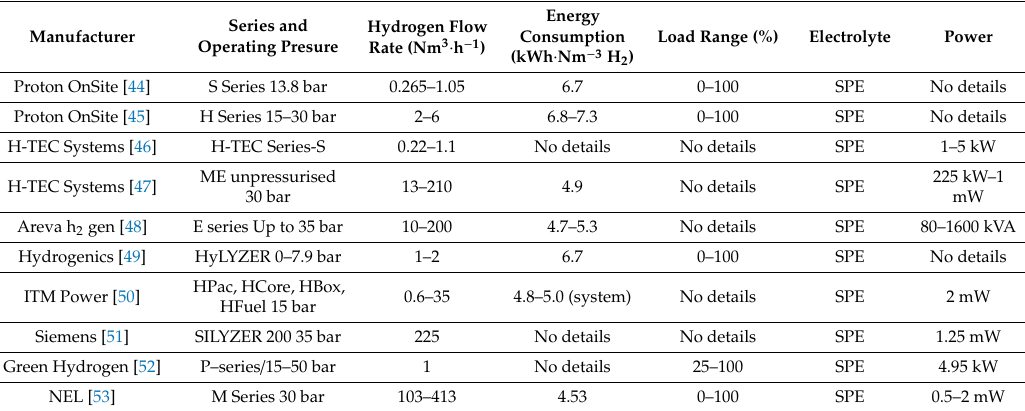
Figure 3. Principle of operation of proton exchange membrane (PEM) electrolyzers. Table 3. Summary of leading manufacturers of PEM